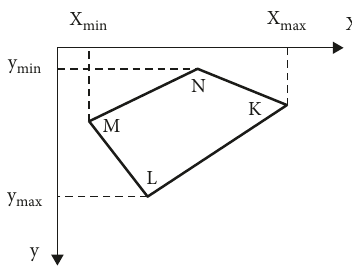
Figure 2: Diagram of four corner points on the coordinate axis.